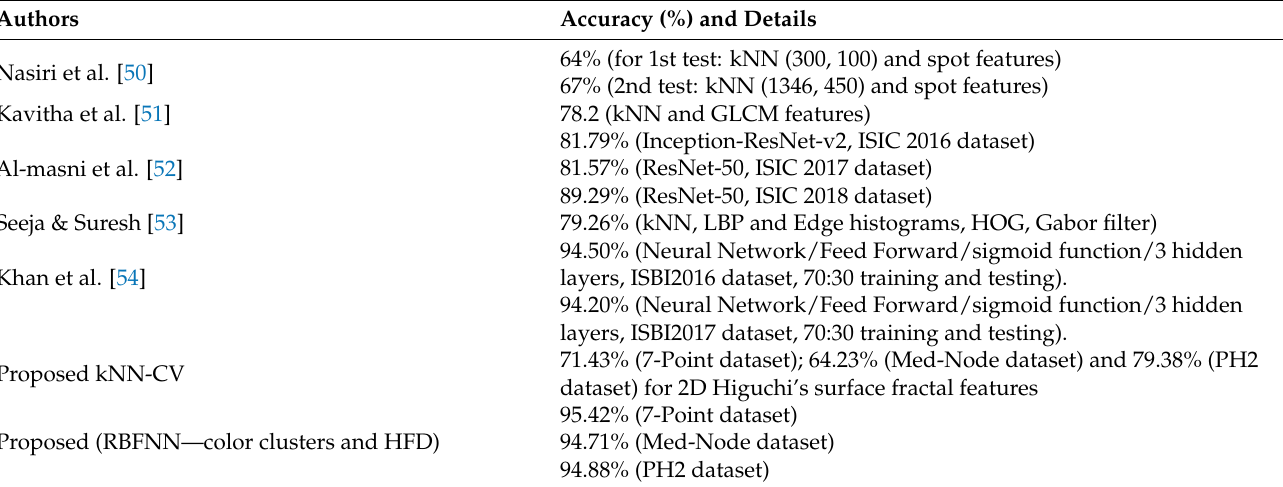
Table 4. The comparison of accuracy results of the proposed method with those of existing